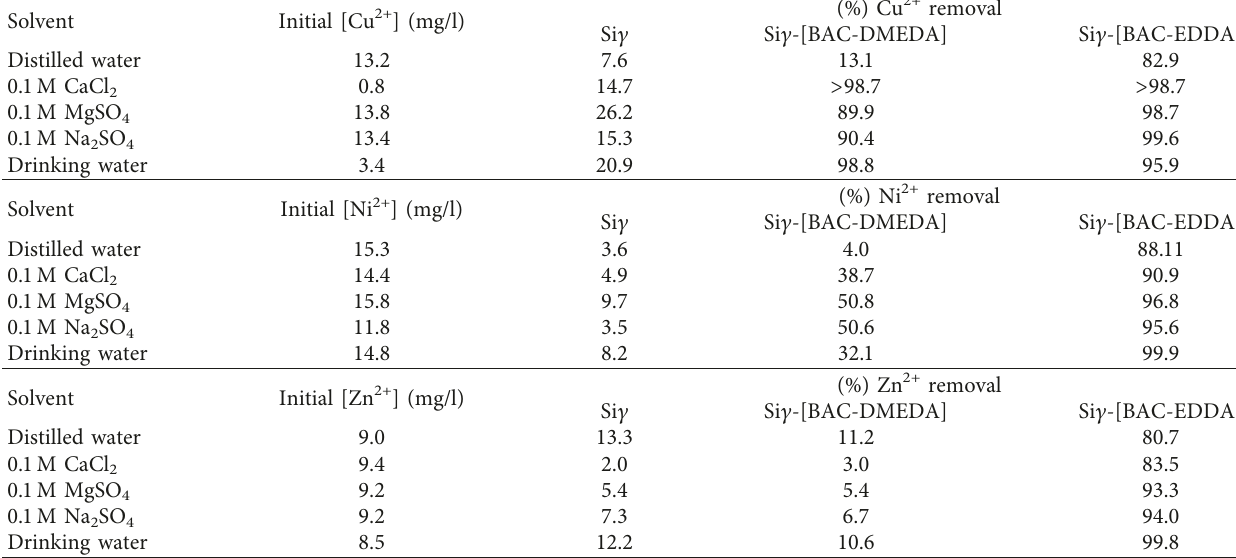
Table 4: Initial heavy metal concentration and ion removal after elution on Si c , Si c -[BAC-DMEDA], and Si c -[BAC-EDDA].